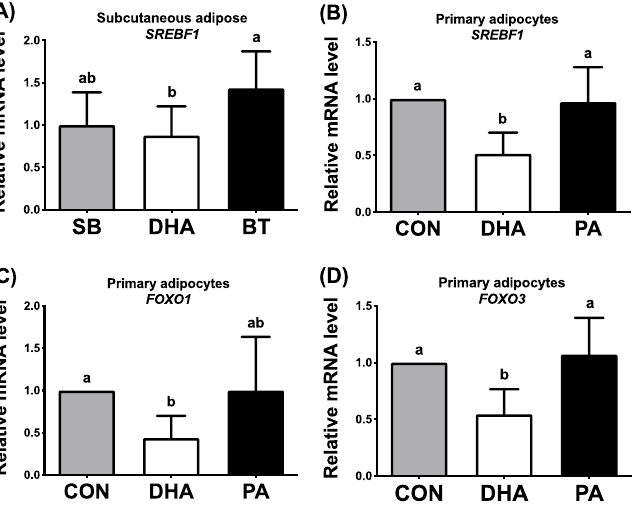
Figure 6. Expression of porcine SREBP-1c, FoxO1 and FoxO3 in DHA-supplemented adipose tissues or primary adipocytes. ( A ) Expression of sterol regulatory element-binding protein 1c (SREBP- 1c/ SREBF1 ) in subcutaneous adipose tissues of weaned pigs, supplemented with 2% soybean oil (SB), docosahexaenoic acid oil (DHA) or beef tallow (BT) for 30 days. The mRNA was determined by qPCR ( n = 6–8 for each group). Expression of SREBP-1c/ SREBF1 ( B ), forkhead box O1 (FoxO1) ( C ), and FoxO3 ( D ) in mature adipocytes, differentiated from adipose stem cells/pre-adipocytes. Cells were treated with the vehicle control (ethanol; CON), 100 μM of docosahexaenoic acids (DHA) or 100 μM of saturated palmitic acids (PA) for 24 h and then the mRNA sequence was determined by qPCR ( n = 7 for each group). Data were expressed as mean ± SD and normalized to β-actin expression in the same sample. Data were analyzed by ANOVA. Different superscript letters (a, b) indicate significant difference ( p ≤ 0.05) determined by Tukey’s multiple comparison test.